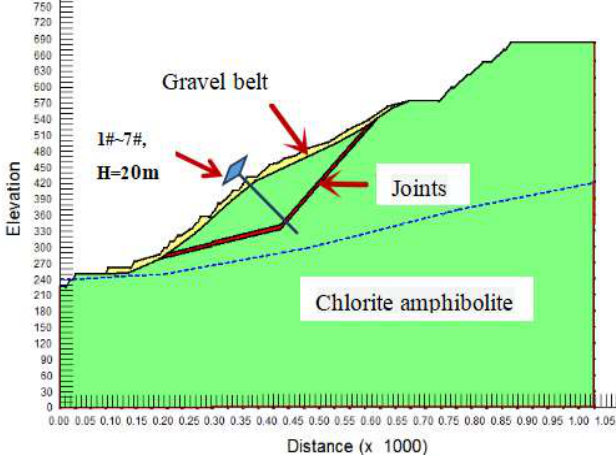
Figure 9. Slope geological model.